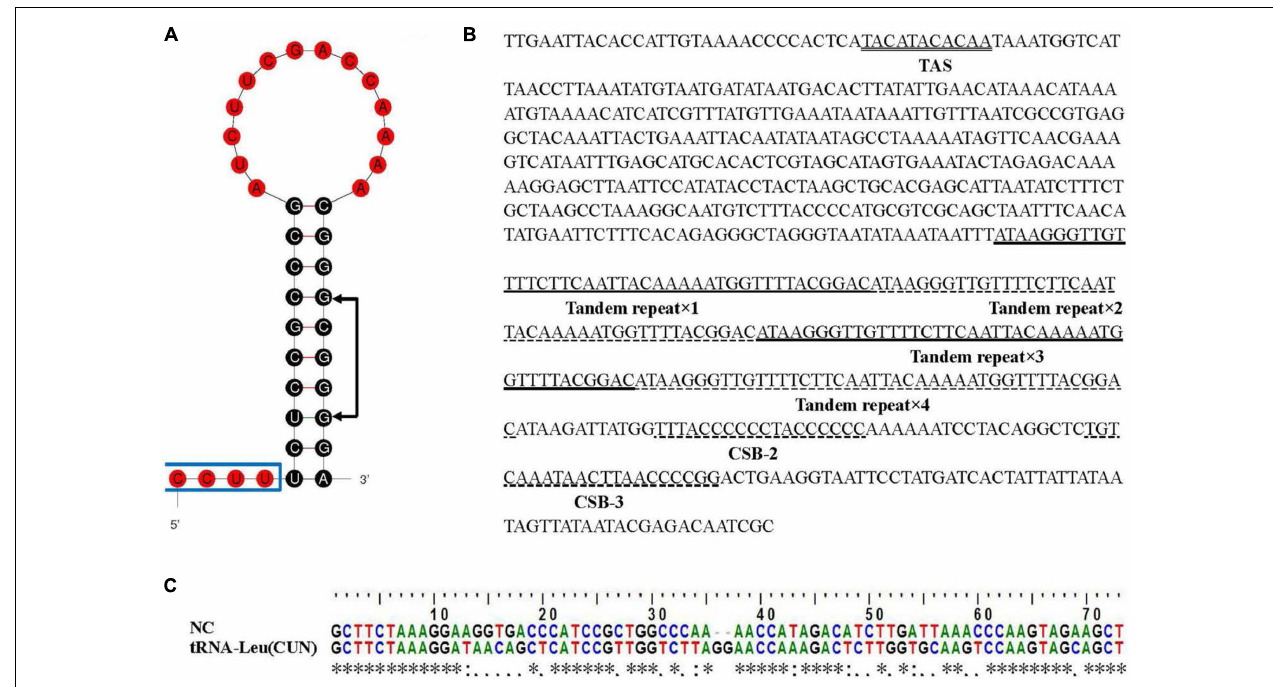
FIGURE 2 | Non-coding regions in the Eleutheronema rhadinum mitogenome. (A) The O L stem-loop secondary structure. The conserved motif 5 (cid:48) -GCCGG-3 (cid:48) was indicated with arrows. (B) Control region in the E . rhadinum mitogenome. Termination associated sequence (TAS), conserved sequence blocks (CSB-2 and CSB-3) and tandem repeats are underlined. (C) Sequence alignment between NC and tRNA-Leu (CUN). * means the corresponding two bases are the same, : means the corresponding two bases are matched, and . means the corresponding two bases are mismatched.